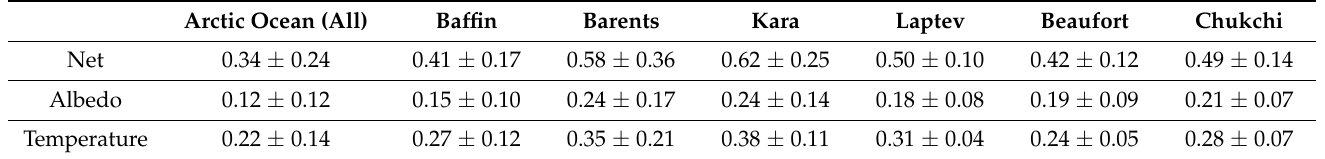
Table 2. SIRFs annual change according to region (W/m 2